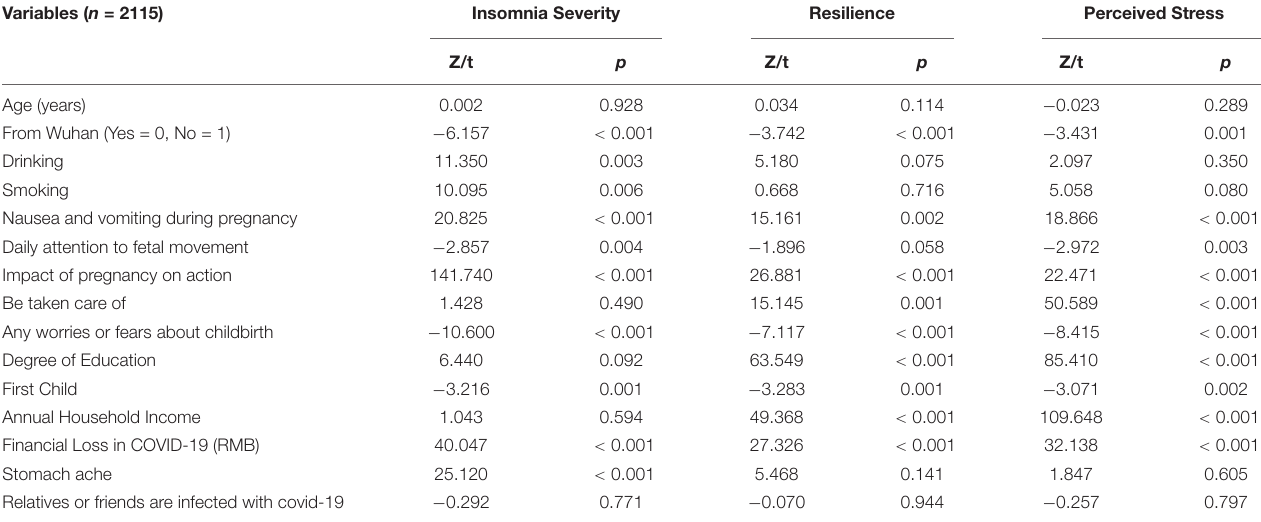
TABLE 1 | Demographic status of the sample.